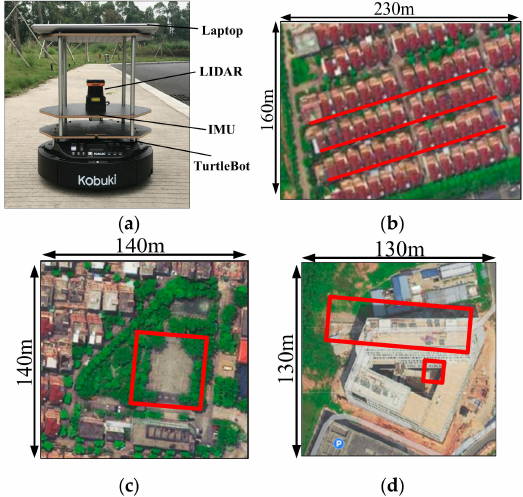
Figure 8. Experimental platform and real-world environments: ( a ) Turtlebot2 for data capturing; ( b ) scene A: long corridors; ( c ) scene B: empty space; ( d ) scene C: tangled thicket. The red lines in scene A show three parallel long corridors, and each corridor is surrounded by two parallel walls without prominent features. The red square in scene B shows an open square. The red square in scene C show area with tangled